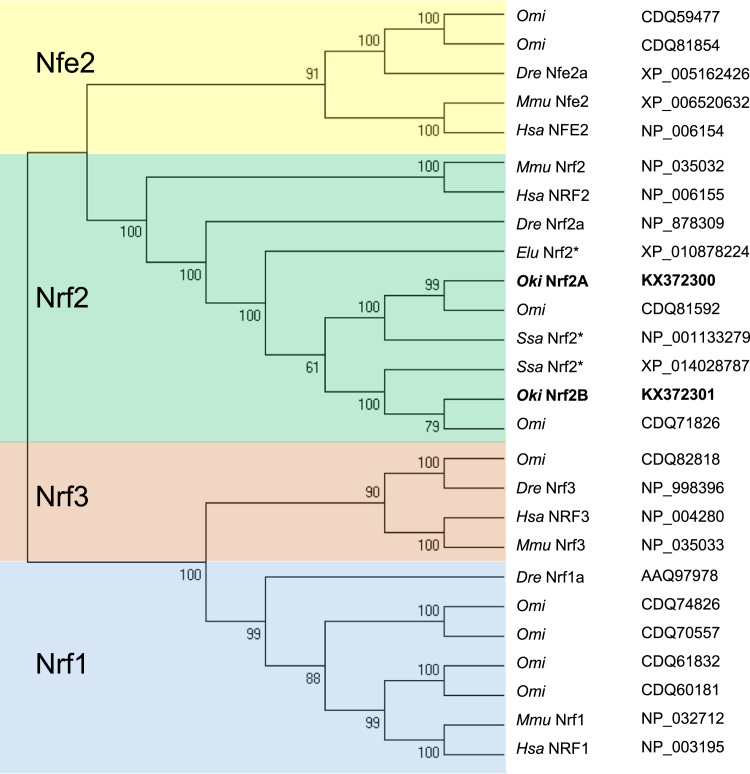
Phylogenetic tree reveals relational grouping of Nrf-like proteins from rainbow trout. The tree was constructed using MEGA6 and its maximum likelihood method with previously curated protein sequences for human, mouse, and zebrafish deposited in GenBank and unknown syntenically related protein sequences from the rainbow trout genome database (http://www.genoscope.cns.fr/trout/) with additional sequences for pike (GenBank) and the coho paralogs (this study). Branch numbers represent frequencies (%) of presented tree topology after bootstrapping (500 iterations). Mmu, mouse; Hsa, human; Dre, zebrafish; Omi, rainbow trout; Oki, coho; Elu, northern pike. Paralogs described in this study, bold. *Predicted identity in NCBI database.